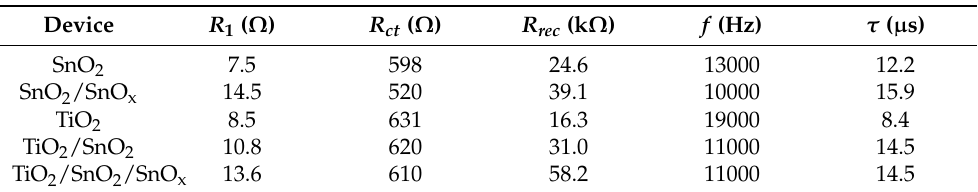
Figure 6. Bode phase plots of PSCs fabricated with the different conditions of ETL in dark condition and an equivalent circuit of solar cell in the inset. Table 3. Electrochemical parameters fabricated with the different conditions of ETL calculated from EIS analysis.